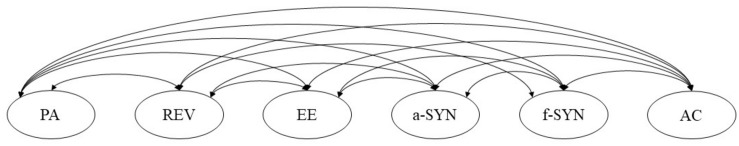
The hypothetical correlated six-factor model.